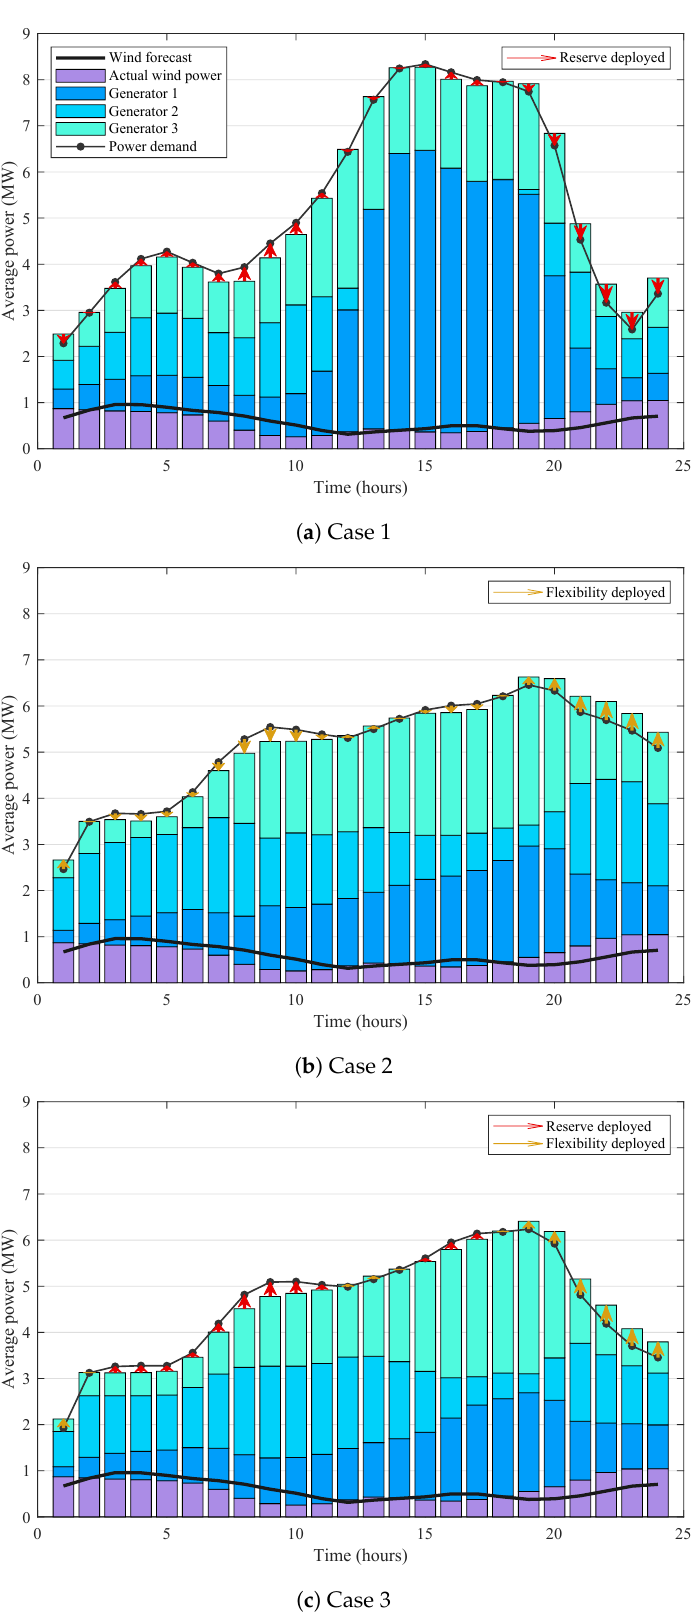
Figure 4. Power balance in the TSO network, showing the wind-power forecast (lower solid line), actual wind power (purple bars), and reserve and flexibility deployment in bright red and yellow, respectively. Other colored bars represent production by conventional